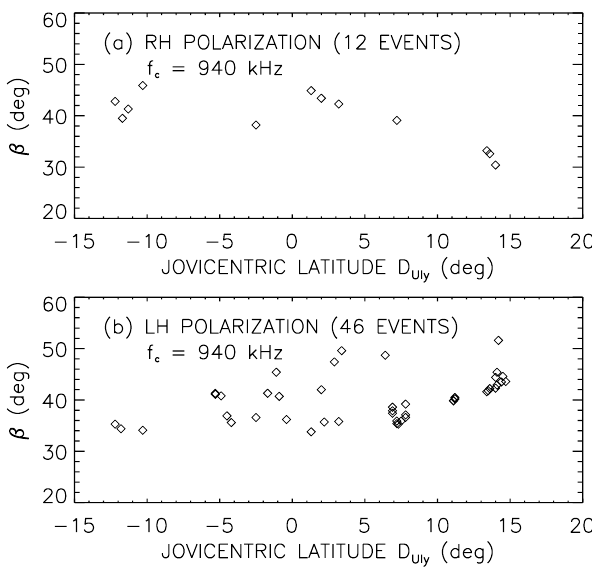
Fig. 10. Calculated values of emission cone half-angle β , for the events represented in Fig. 4, against jovicentric latitude for (a) the northern jovimagnetic hemisphere source (RH), and (b) the south- ern jovimagnetic hemisphere source (LH). A dipole magnetic field is assumed and an emission frequency of 940kHz from a source on L-shell ’